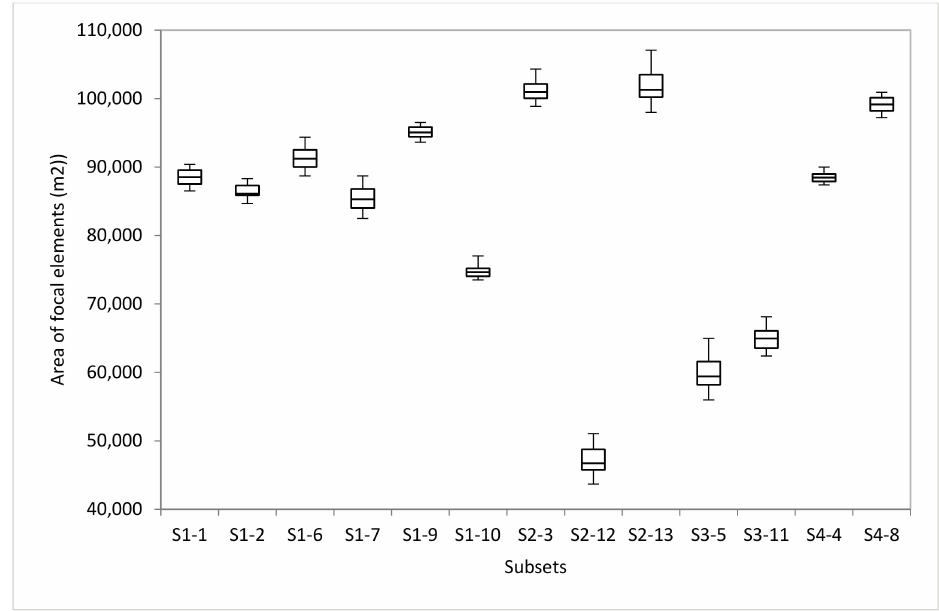
Figure 10. Statistical distribution of area of focal elements sampled from 13 random sets (see notations in Figure 7 for the name of subsets).